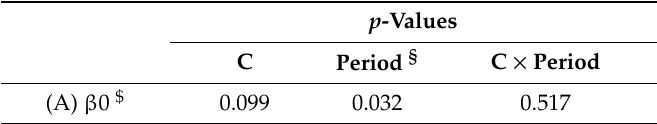
with 35% concentrate feed proportion ( C 35 , blue , n = 7) in the ration. Table 4. p -values of e ff ects of concentrate proportion of the diet (C), period and the interaction between Table 4. p -values of effects of concentrate proportion of the diet (C), period and the interaction them on daily pH variation ( β 0). between them on daily pH variation ( β 0).